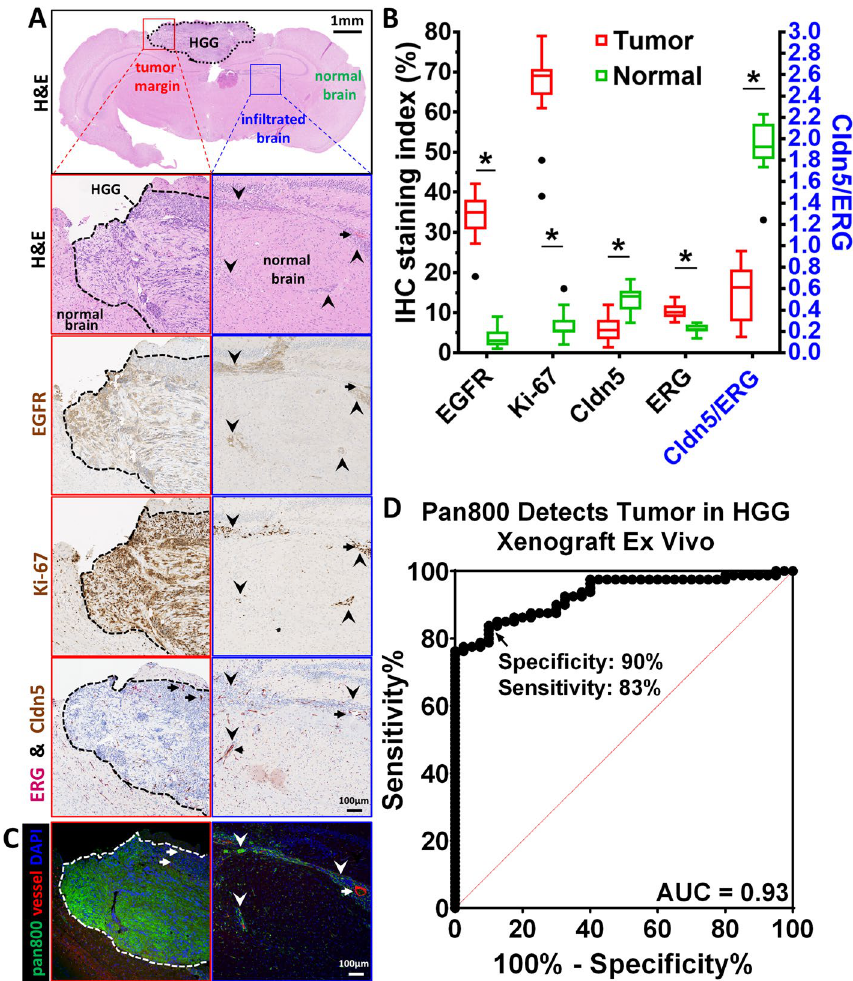
Figure 4. Tumor biomarkers and microscopic NIRF imaging of panitumumab-IRDye800 in HGG xenograft. ( A ) Histology (H&E) and immunohistochemistry staining of 4 µm sections of HGG xenograft bearing mouse brains 14 h post panitumumab-IRDye800 injection. EGFR: epidermal growth factor receptor; Ki-67: nuclear protein associated with cellular proliferation; Cldn5: tight junction protein, claudin-5; ERG: erythroblast- transformation-specific related gene (a vascular endothelial marker). Red boxes : primary HGG core and normal brain margin ( black dotted line ); Blue boxes : HGG cells infiltrating normal brain; Arrows : blood vessels; arrowheads : infiltrating HGG tumor cells. ( B ) IHC staining index (left Y axis) and Cldn5/ERG ratio (right Y axis, blue) of tumor areas ( n = 16) and normal brains ( n = 10), respectively (*P < 0.001). ( C ) NIRF microscopic imaging of intratumoral uptake of panitumumab-IRDye800 (pan800, green) in HGG mouse brain sections in the same field of view as ( A ). ( D ) Fluorescence intensity of panitumumab-IRDye800 fluorescence distinguishes tumor from normal brain in ( C ) with 90% specificity and 83% sensitivity. AUC: area under the curve; ROC: receiver operating